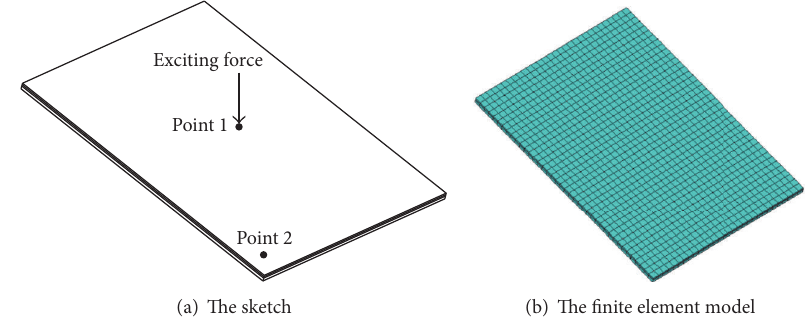
Figure 4: Flat panel